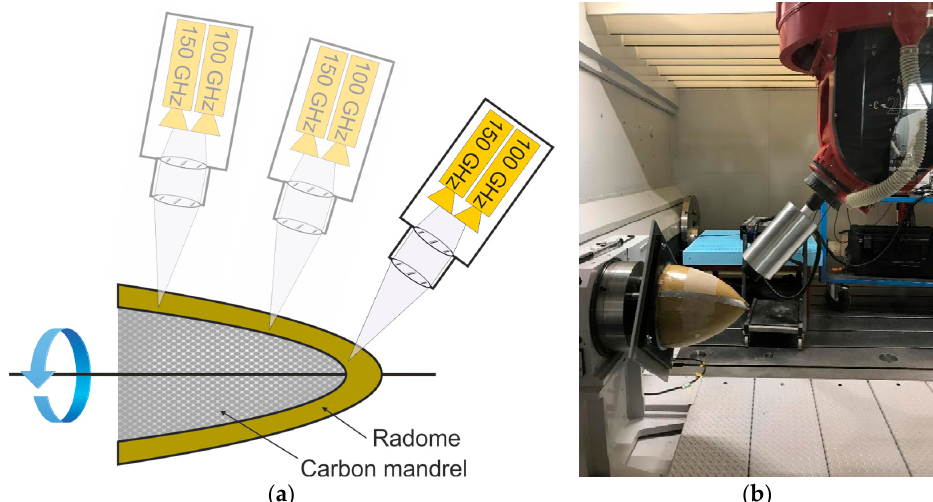
Figure 5. ( a ) Schematic drawing of the measurement procedure. A machining head moves the terahertz sensor head at a fixed distance perpendicular along the surface of the radome, which in turn is rotated around its longitudinal axis. In this way, a full three-dimensional image of the radome is acquired. ( b ) Photograph of the sensor unit mounted on a robotic arm of the machining center in a realistic measurement environment.